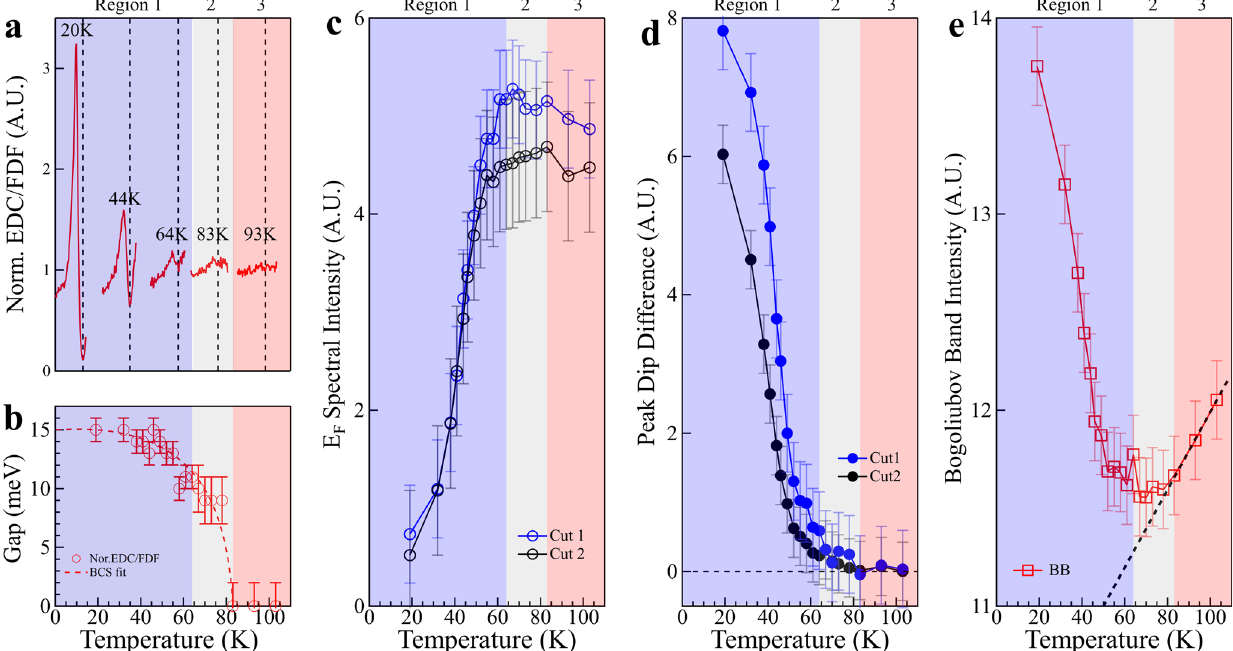
Fig. 4 Summary of various temperature-induced changes in single-layer FeSe/STO fi lms that can be categorized into three temperature regions. All the results can be divided into three regions: in region 3, 83 – 103 K, the sample is in normal state with no Bogoliubov back-bending band, zero gap and no suppression of spectral weight at the Fermi level. In region 2, 64 – 83 K, there are signatures of Bogoliubov back-bending band, gap opening, and suppression of spectral weight at the Fermi level. But the changes with temperature in this temperature region is small. In region 1, below 64 K, Bogoliubov back- bending band, gap opening, and suppression of spectral weight at the Fermi level are obvious and change dramatically with the temperature decrease. a Representative normalized EDCs in three regions. These EDCs are taken from Fig. 3b, c. The vertical dashed lines show the Fermi level for each EDC. b Temperature dependence of the energy gap along a Fermi surface. The data are from Fig. 2f. c Temperature-induced spectral weight change at the Fermi level for the momentum Cut 1 (blue empty circles) and Cut 2 (black empty circles). The data are from Fig. 2g for Cut 1 and from Fig. 3e for Cut 2; they are normalized for comparison. d Temperature dependence of the difference between the peak height and the dip height from the normalized EDCs for Cut 1 (blue solid circles) and Cut 2 (black solid circles). The data are from Fig. 2g for Cut 1 and from Fig. 3e for Cut 2; they are normalized for comparison. e Temperature dependence of the spectral weight of the superconductivity-induced Bogoliubov back-bending band. The data are from Fig. 3d. Error bars re fl ect the uncertainty in determining the EDC peak position and spectral